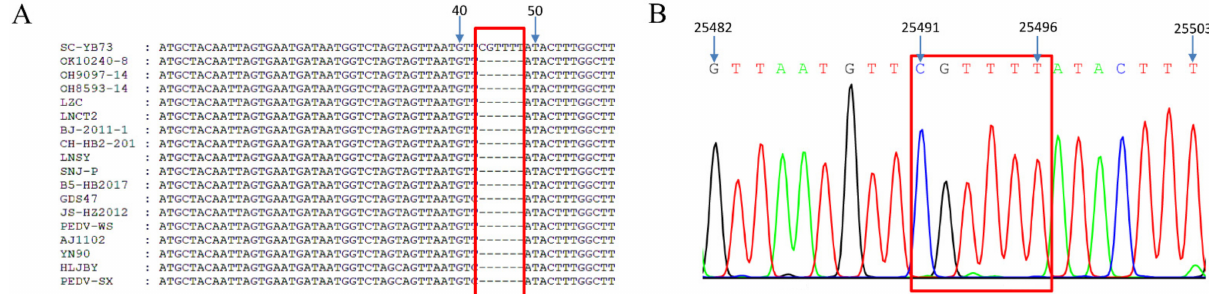
Figure 3. Multiple sequence alignment of E gene of PEDV strains ( A ) and partial-Sanger-sequencing peak map for SC-YB73 ( B ). The red box was present the six nucleotide acid insertions.